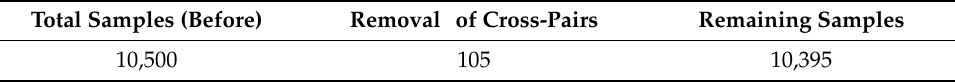
Table 3. Cross-Pairs Identification and